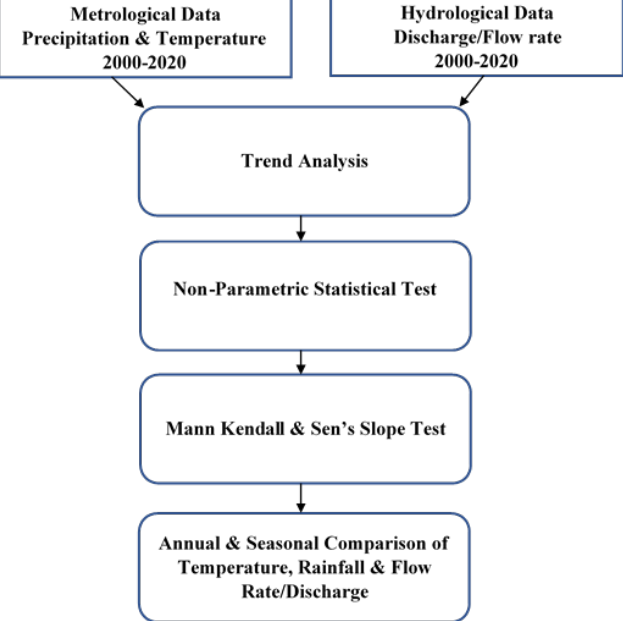
Figure 2: Flow chart diagram illustrating the